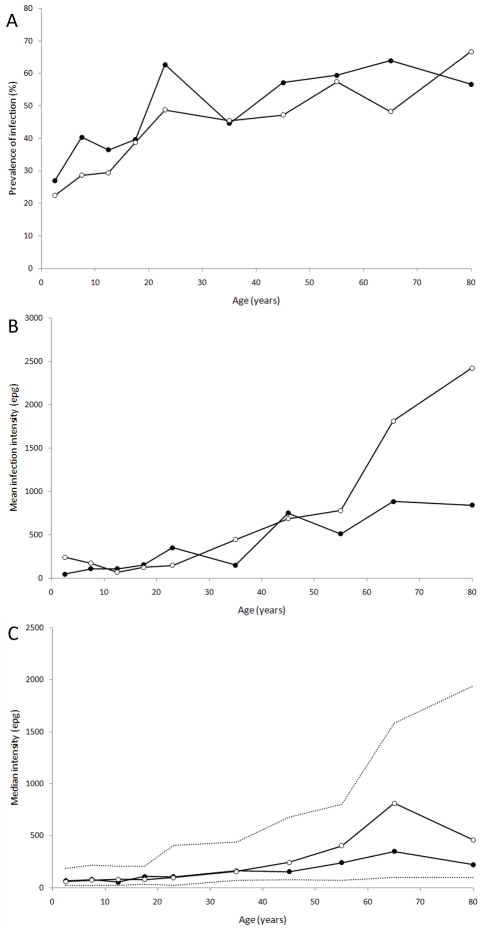
Age-sex distributions for hookworm infection.(A) prevalence of hookworm infection, (B) mean intensity of infection, in epg, and (C) median intensity of infection (in epg) for those infected only (dashed lines indicate the population interquartile range). Males, closed circles; Females, open circles.